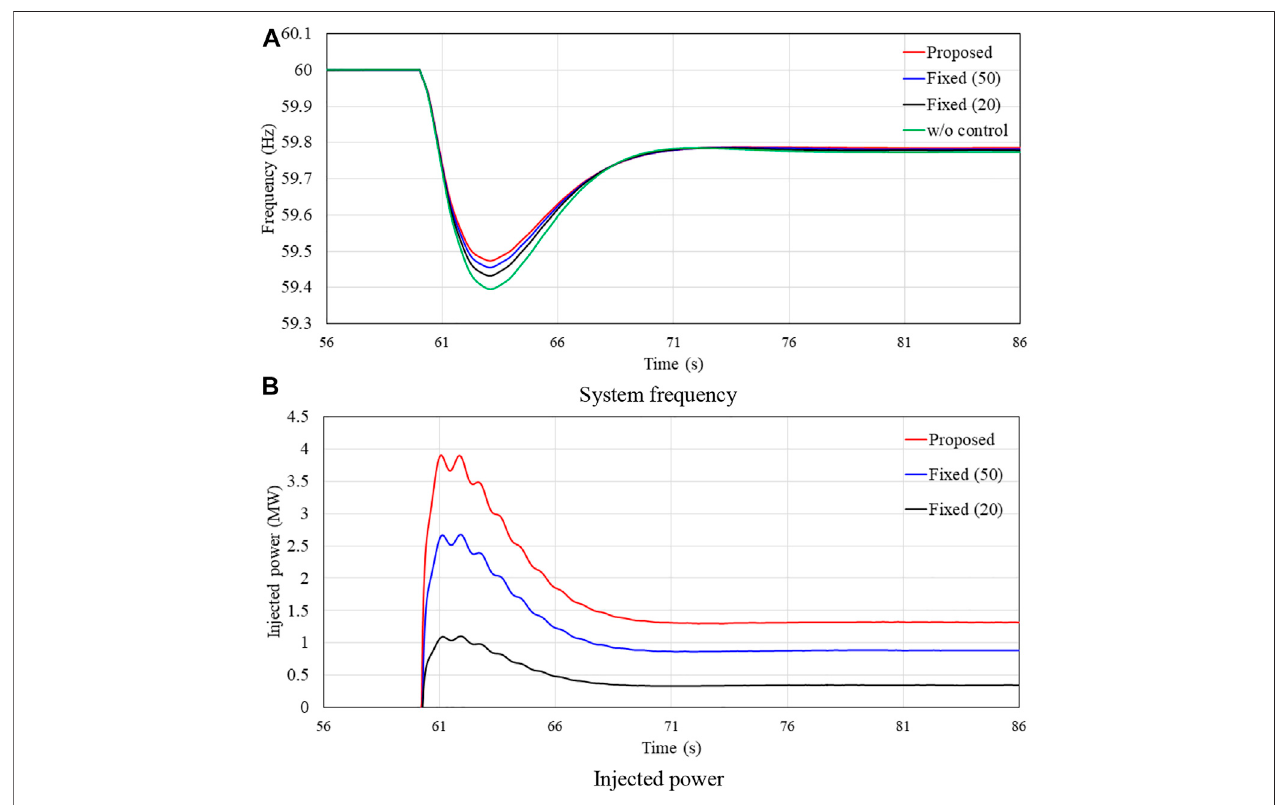
FIGURE 8 | Results for case 3 with light disturbance. (A) System frequency. (B) Injected